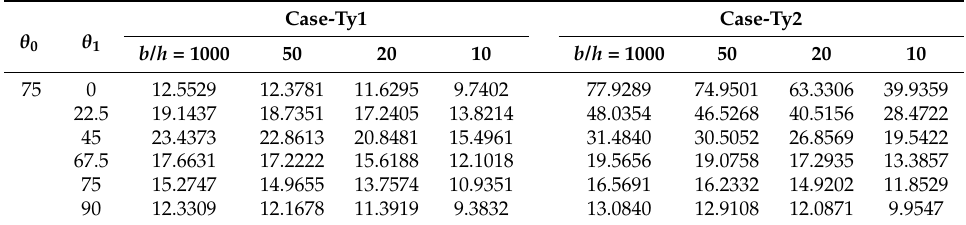
(cid:16) (cid:17) 2 b T cr α 11 for [ ± < θ 0 | θ 1 > y ] s laminates h π 2